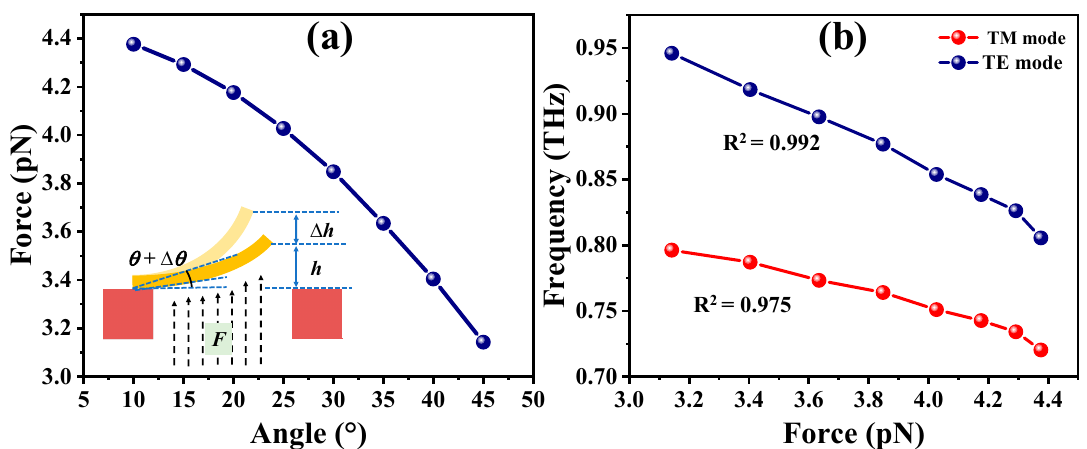
Figure 7. ( a ) Relationship of cantilever bending angles and induced bending forces. ( b ) Relationships of resonances and induced bending forces of MTM in TM and TE modes.